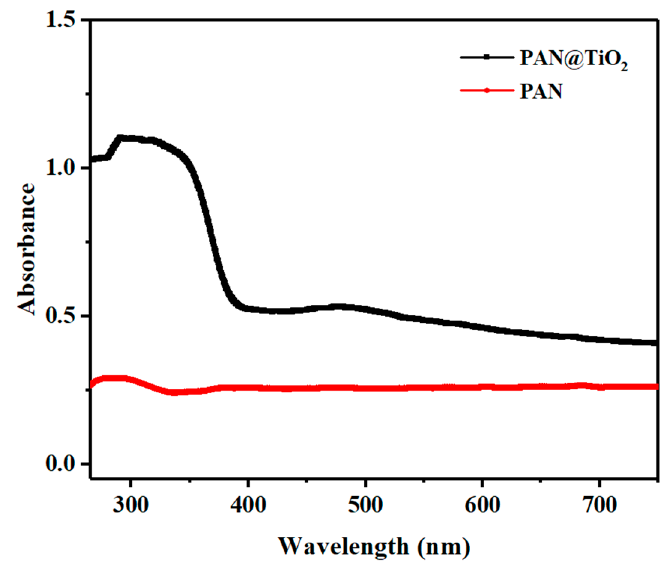
Figure 5. UV–vis diffuse reflectance spectra of PAN and PAN@TiO 2 nanofibers.